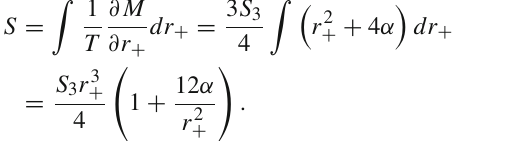
C P of the black hole, at α = 0 . 5 and k = 0 . 4. The blue, red, and green curves correspond to 9 S 3 , 1 , 1 , 5 10 100